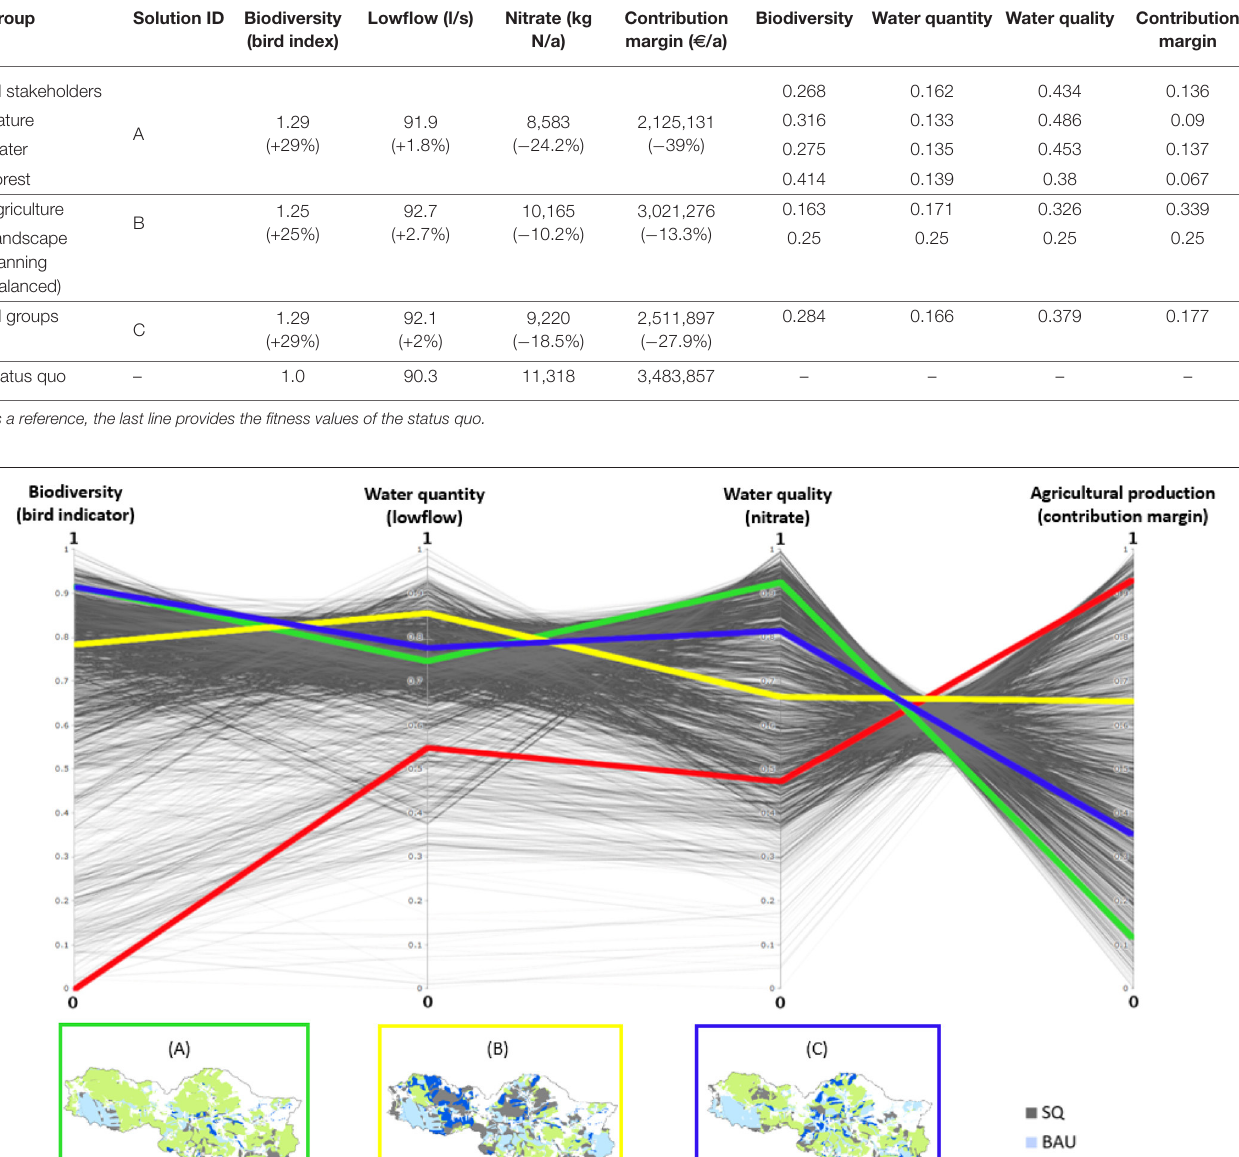
Frontiers in Water |